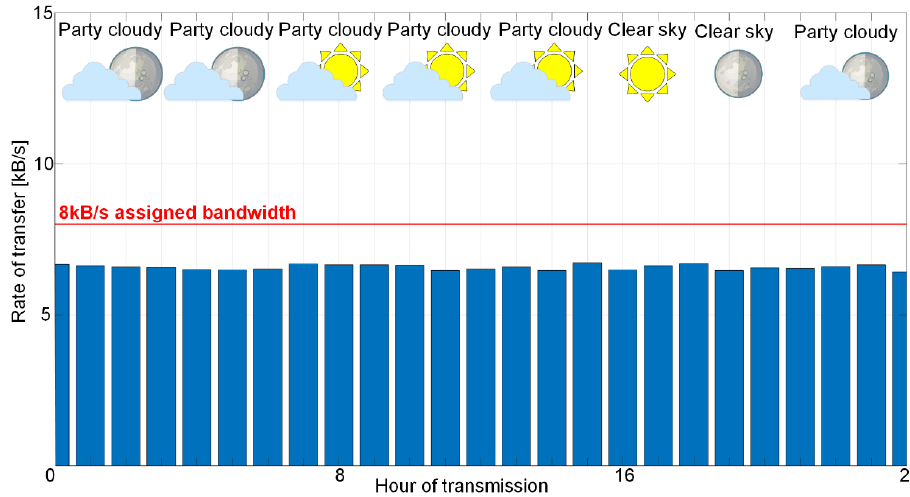
Figure 9. Transfer rate during favorable weather conditions.